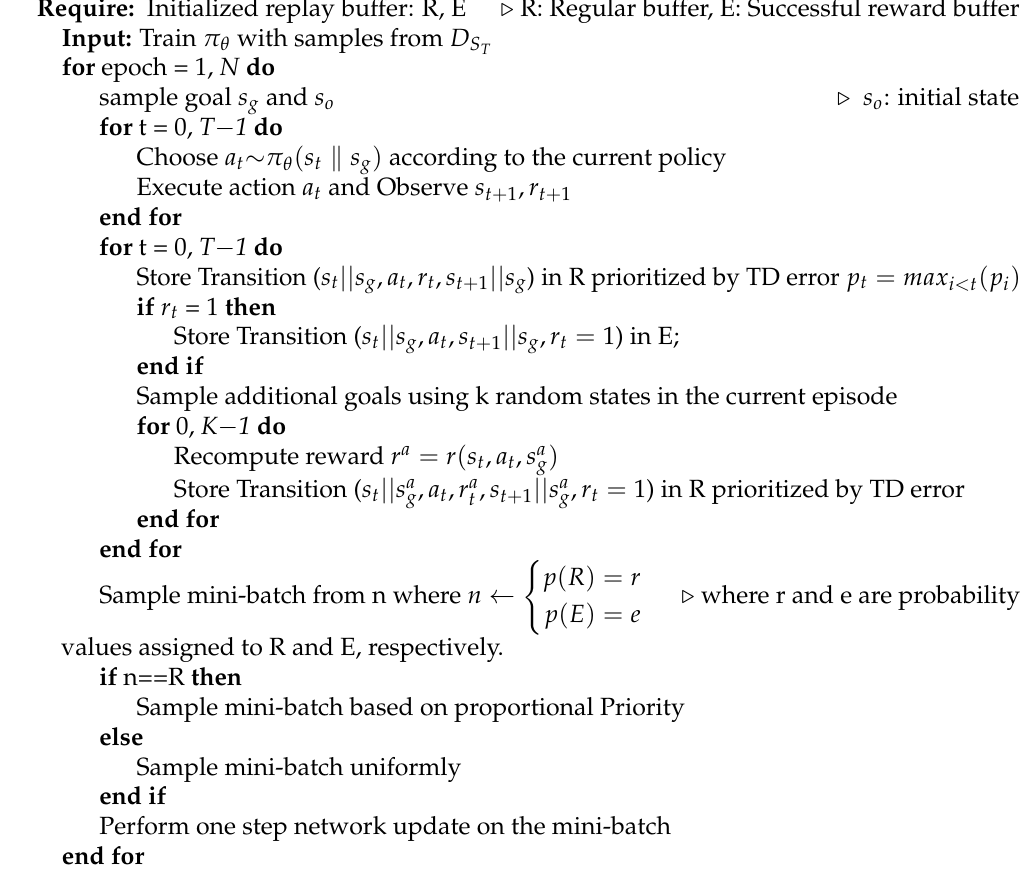
Algorithm 1 SAC + HER + PER with separate replay